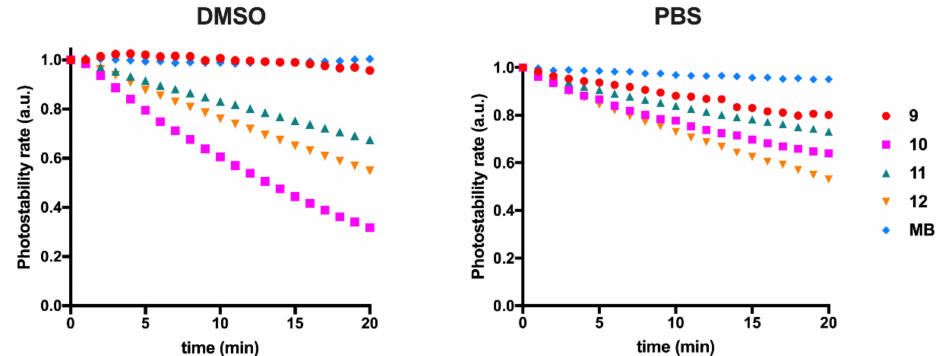
Figure 3. Photostability rate, in arbitrary units (a.u.), of quinoline- and benzoselenazole-derived unsymmetrical squaraine cyanine dyes 9 – 12 and methylene blue (MB) in dimethyl sulfoxide (DMSO) and phosphate-bu ff ered saline (PBS). Dye solutions were irradiated repeatedly with a light-emitting diode system emitting at 630.2 ± 0.8 nm and radiant flux of 4.3 ± 0.5 mW for periods of 1 min for 20